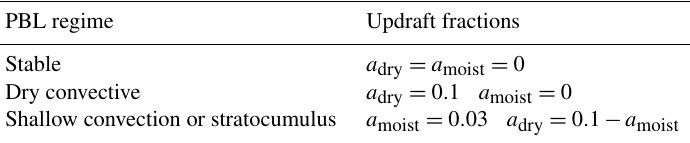
Figure 2. Schematic diagrams of the convective boundary layer regimes and the corresponding entrainment formulations (Eq. 8) of the dry (dashed line) and moist (solid line) updrafts. The inversion height and cloud top height are, respectively, denoted as z i and z t . Note that z i can be different for the moist and dry updrafts and is therefore referred to as z i , dry and z lcl , respectively. The shape of the entrainment profiles reflects the inverse dependency on the vertical velocity of the updraft (Sect. 2.2.1). This is a modified version of Fig. 4 in B17. Table 1. Updraft area fractions per PBL regime in cy40NEW. Constants a dry and a moist are used to determine the initialisation of temperature and humidity excess at the lowest model level of the corresponding updraft (like in N09). Together with the dry updraft vertical velocity, a dry also determines the dry updraft mass flux (see Eq. 3). The moist updraft mass flux, however, is calculated independently of a moist (see Sect. 2.2.2).